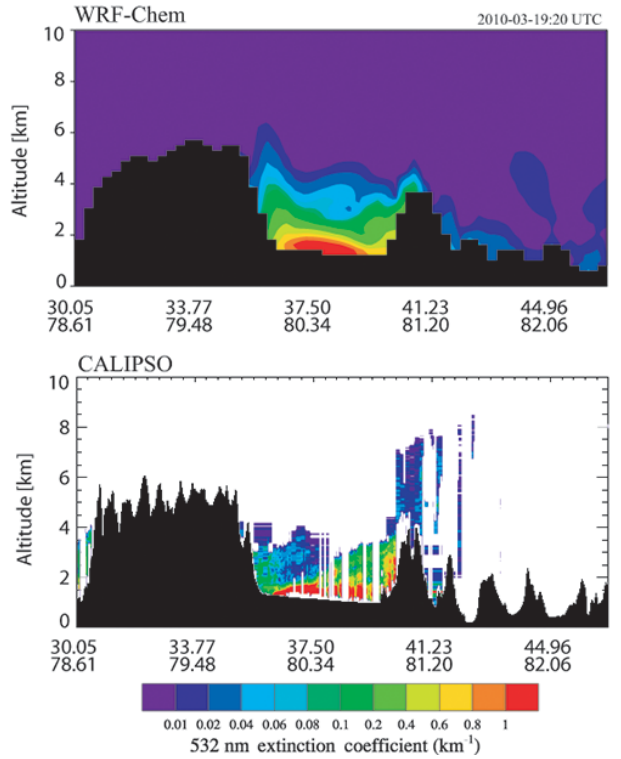
Figure 6. Cross sections of the aerosol extinction coefficients at 532nm (km − 1 ) over the TD at 20:08UTC (02:08LT) on 19 March 2010 from the WRF-Chem model (top) and CALIPSO retrievals (bottom) along the orbit path of CALIPSO (as shown in Fig.